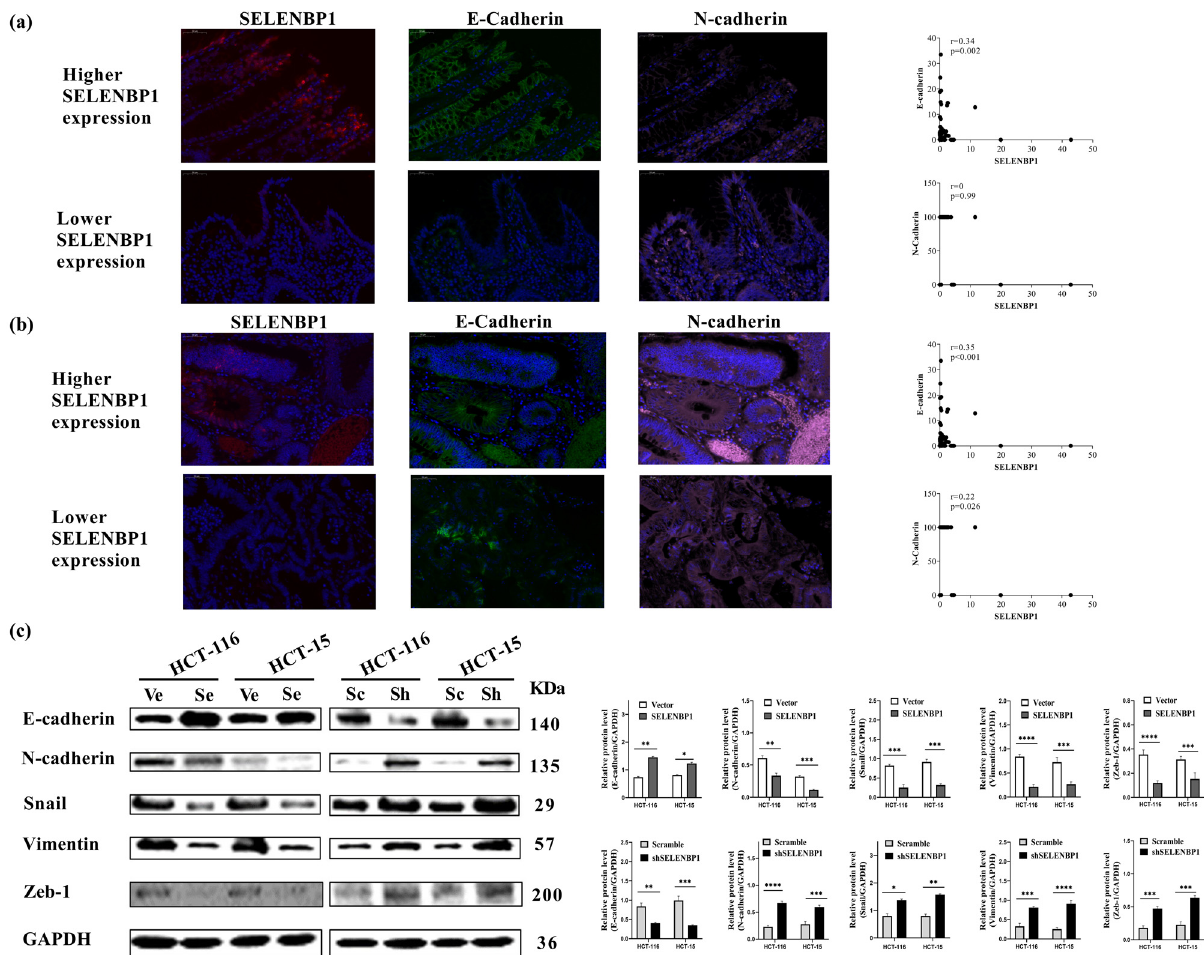
Figure 5: SELENBP1 inhibits EMT in CRC cells. A multicolor IF staining methodwas used to evaluate the expression and localization of SELENBP1 ( red ) , E - cadherin ( green ) , and N - cadherin ( pink ) inNTs ( a ) and CRCs ( b ) , using the TMA cohort ( scalebar = 50 μ m ) . Percent ofpositive cellswere calculated and correlation analyses were conducted based on the expression of these proteins ( scatter plots on the right ) . Total proteins were extracted from HCT - 15 and HCT - 116 cells stably infected with SELENBP1, shSELENBP1, or relative control lentiviruses and were used to